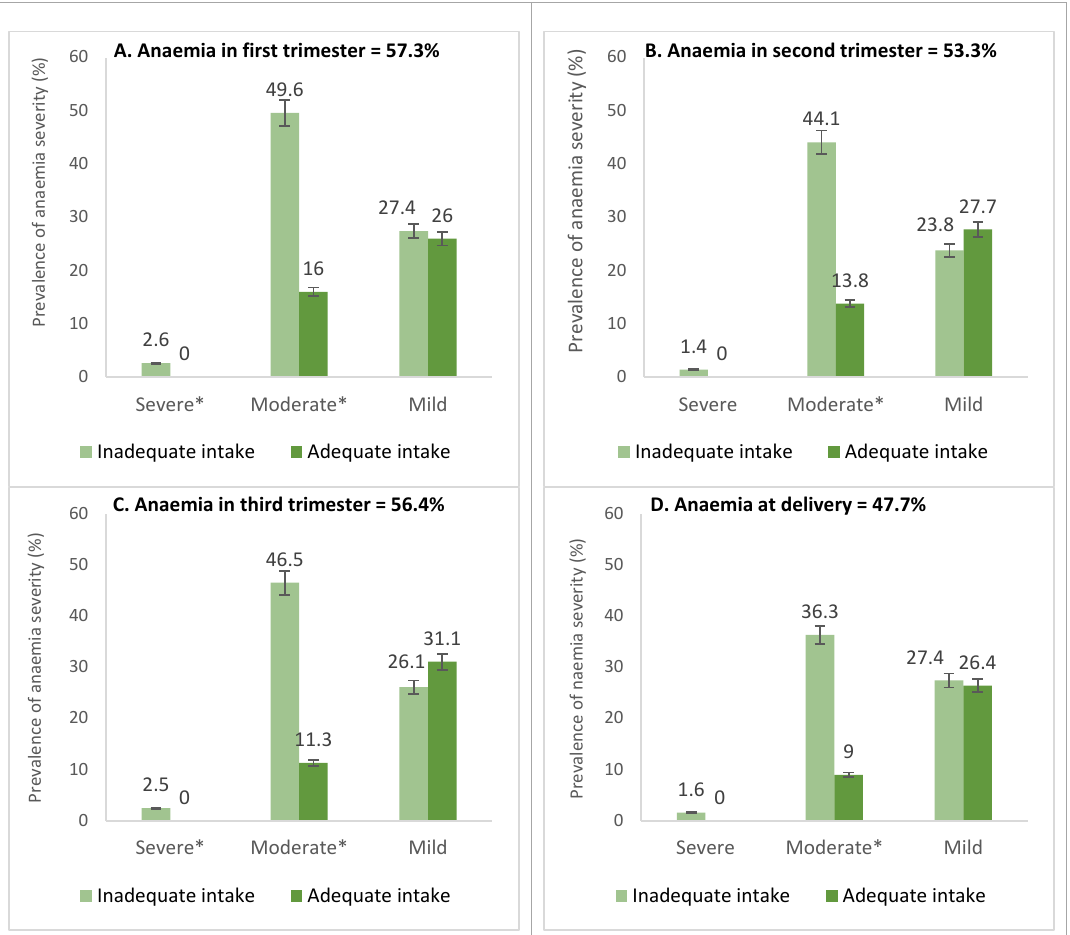
Figure 2. Prevalence and severity of anemia in the( A ) first, ( B ) second and ( C ) third trimesters of pregnancy and ( D ) at the point of admission for delivery stratified according to the adequacy of micronutrient intake. Footnote: *Multiple comparison shows the categories that differed significantly ( p < 0.05). Anemia classified as mild (10.0–10.9 g / dL), moderate (7.0–9.9 g / dL) and severe ( < 7.0 g / dL) (WHO,